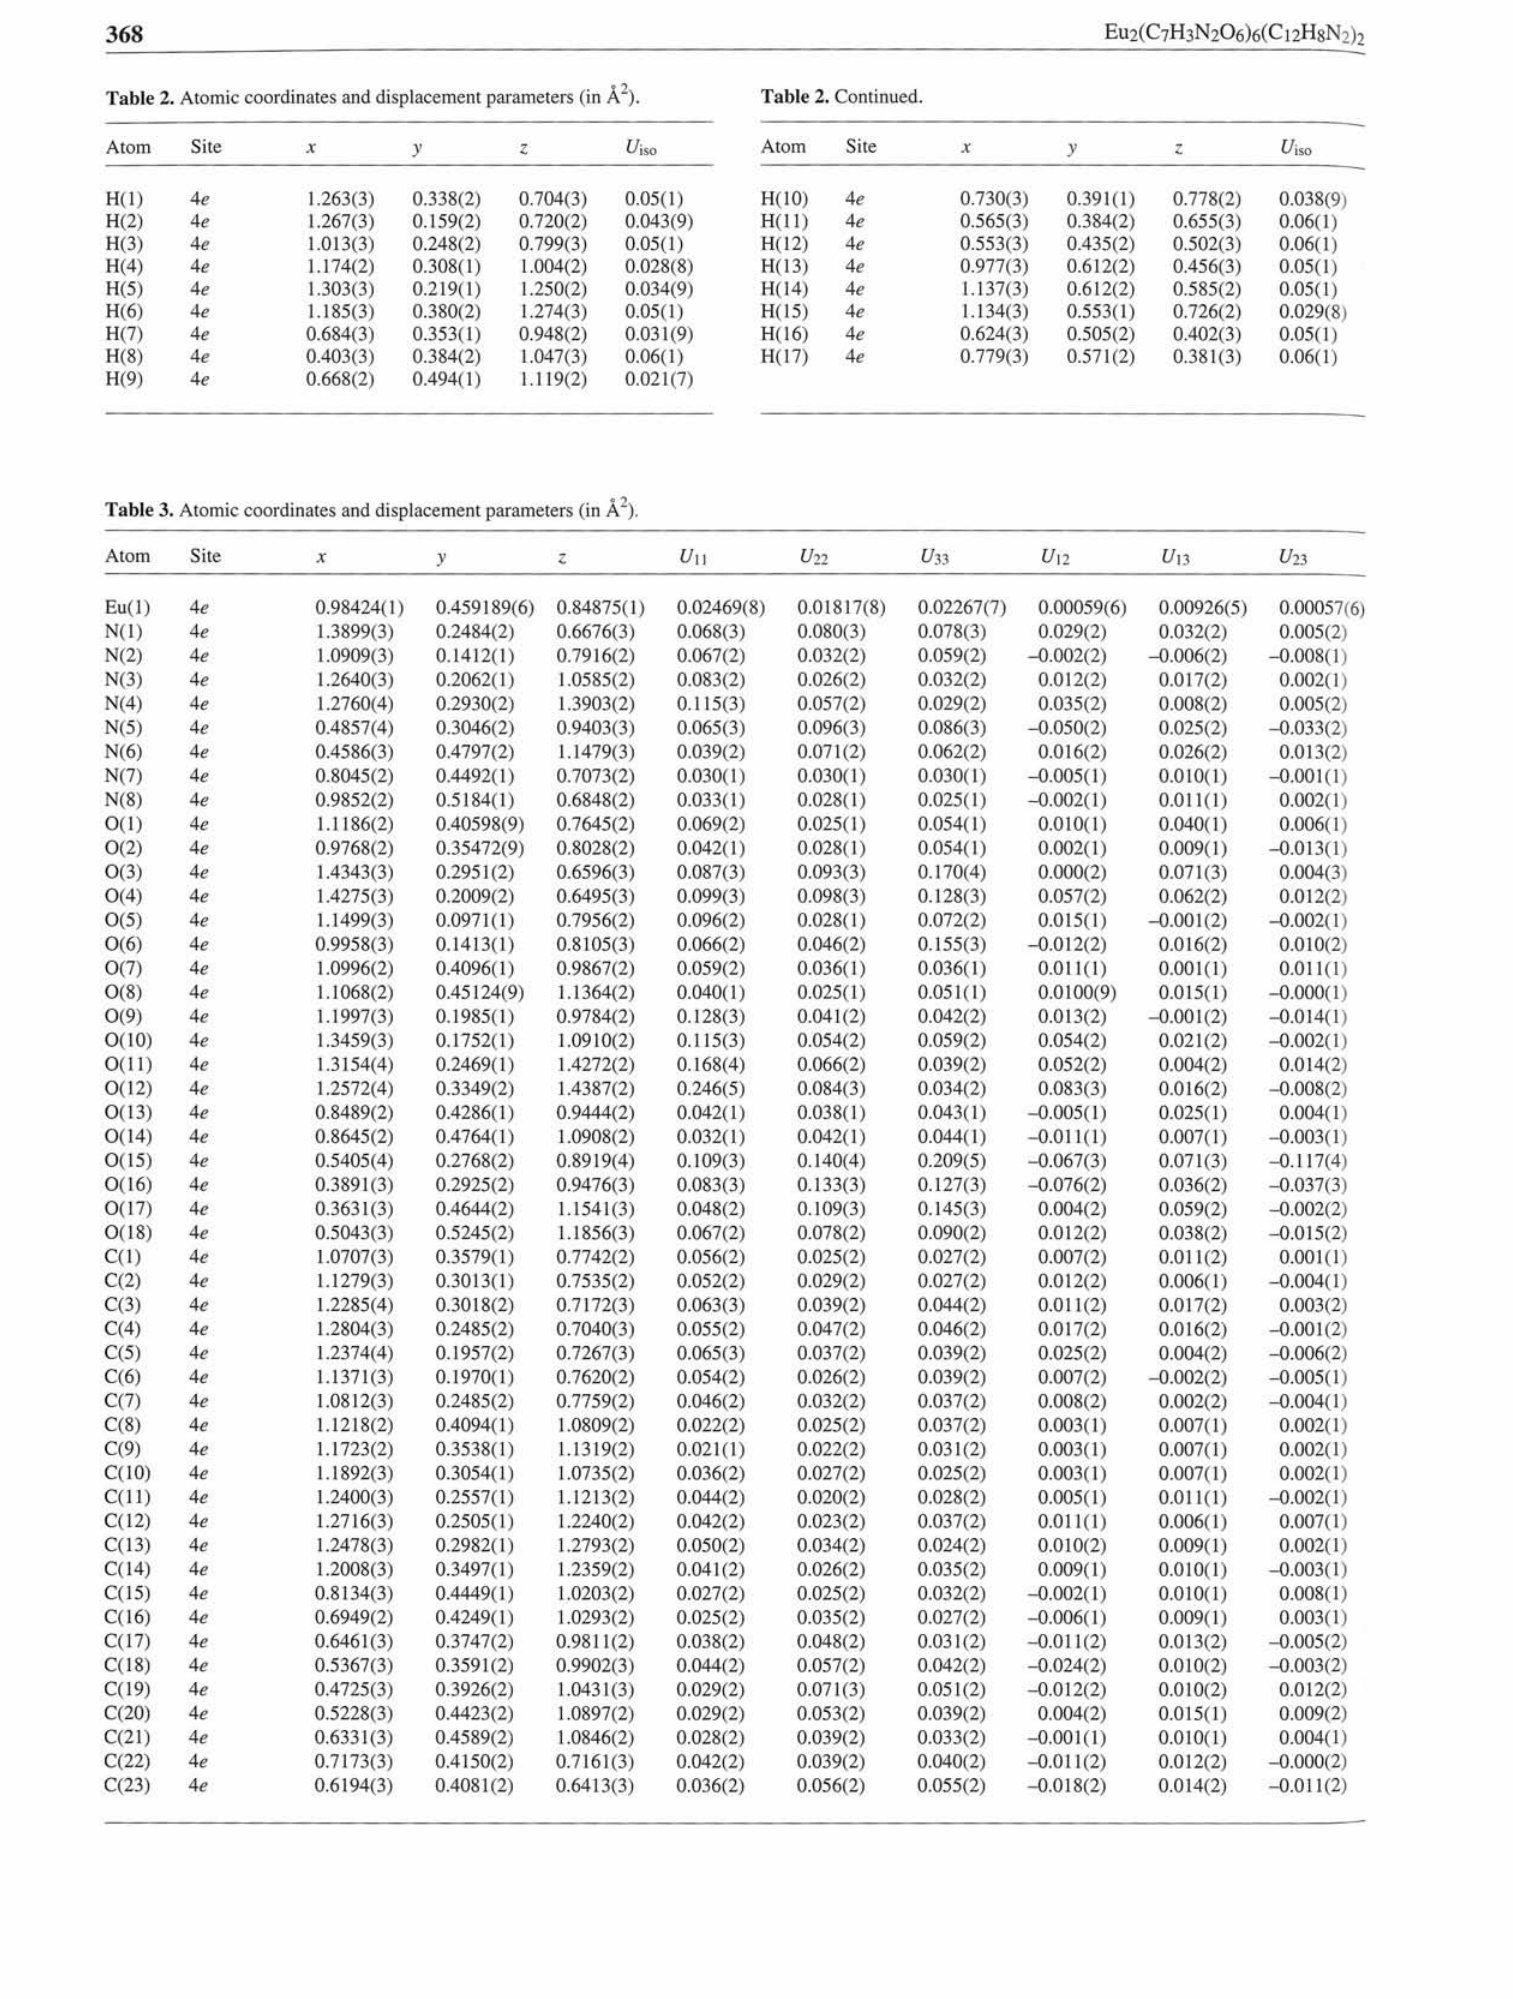
Table 3. Atomic coordinates and displacement parameters (in À 2